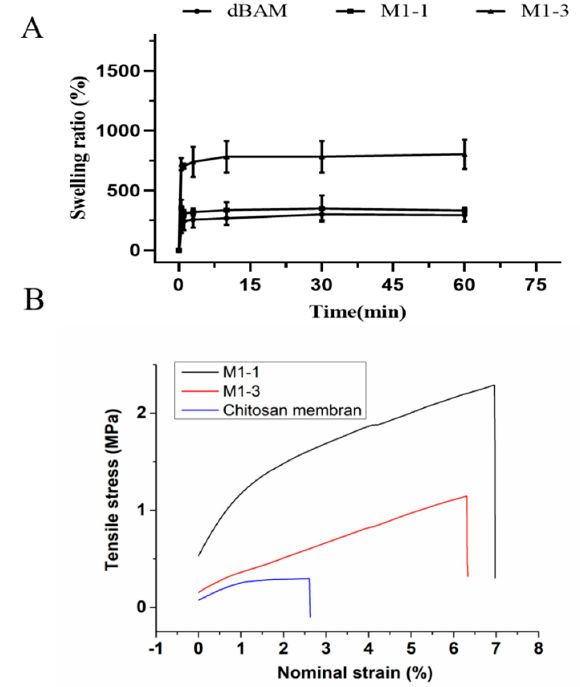
Figure 3. ( A ) Swelling ratios of dBAM, M1-1, and M1-3 (0–60 min), ( B ) the mechanical testing of chitosan membrane, M1-1, and M1-3.